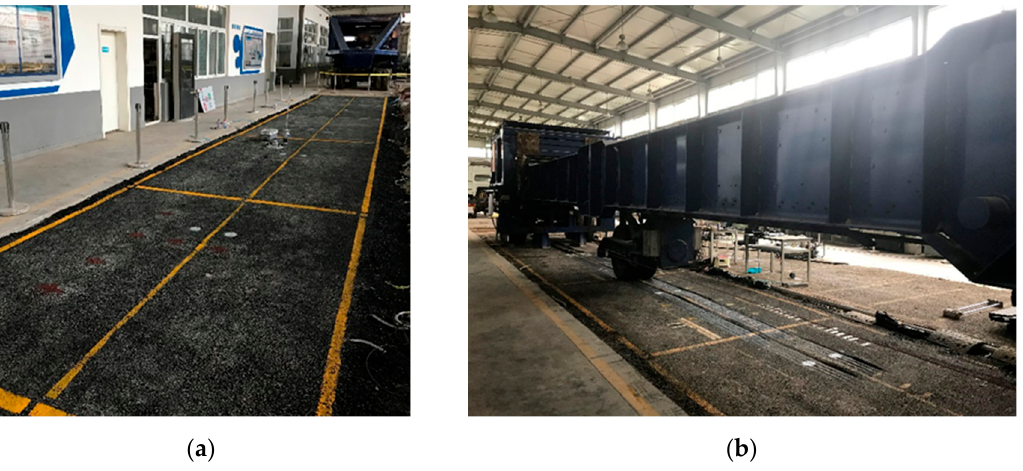
Figure 4. Test sections and accelerated pavement test loading facility: ( a ) test sections; ( b ) APT loading facility.